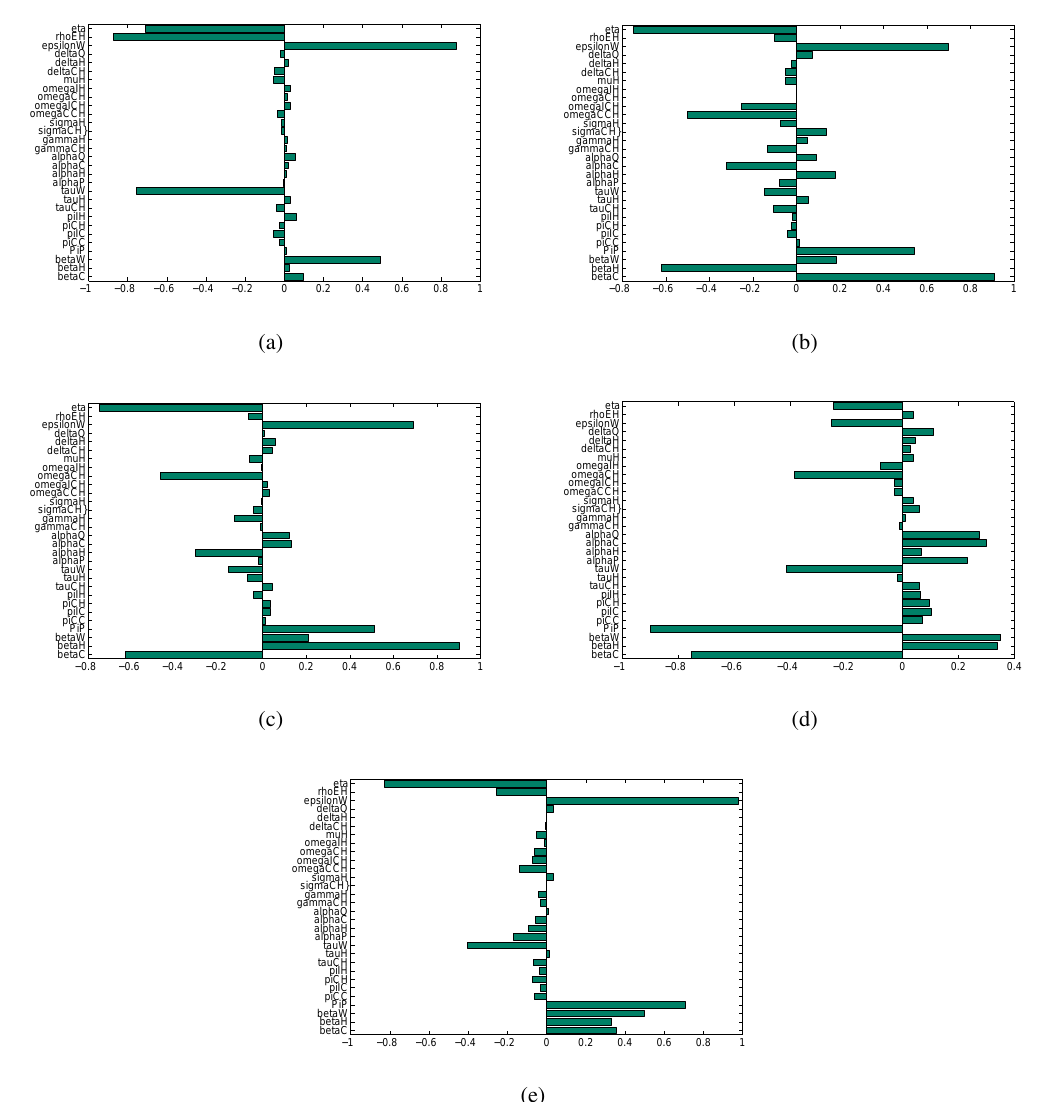
Fig. 2. PRCC for the model (2.1), using as output (a) R HC ; (b) prevalence of CA-MRSA among patients; (c) prevalence of HA-MRSA among patients; (d) prevalence MRSA among health-care workers; (e) the hospital